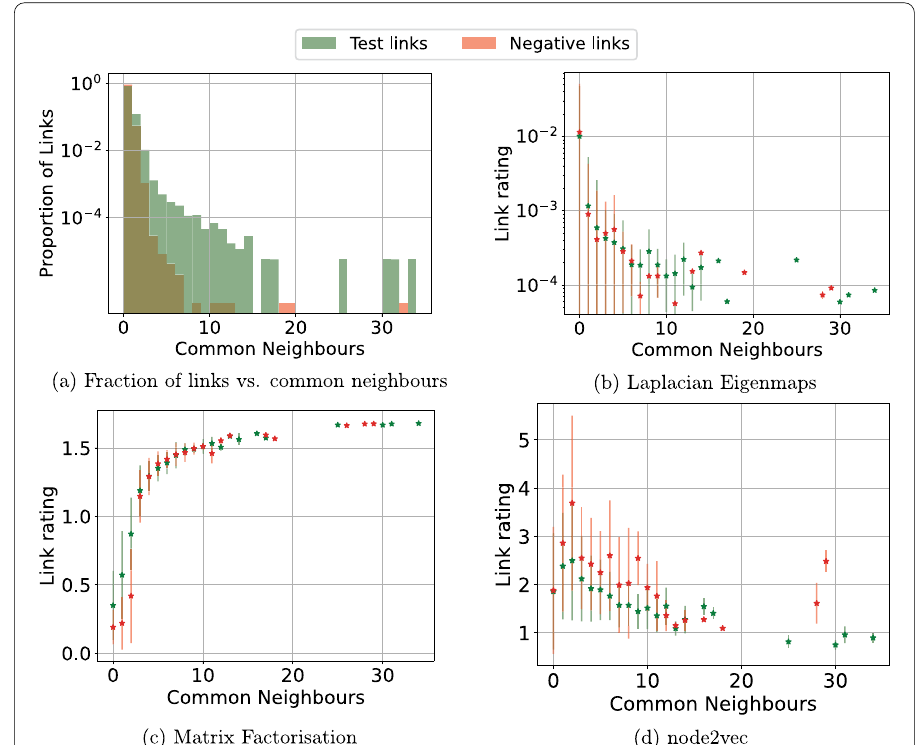
Fig. 1 a Fraction of links of the generated networks ( γ = 2.50 , β = 0.00 ) that share a given number of neighbours. Average rating of negative and test links with a given number of common neighbours derived by b Laplacian Eigenmaps, c Matrix Factorisation, and d